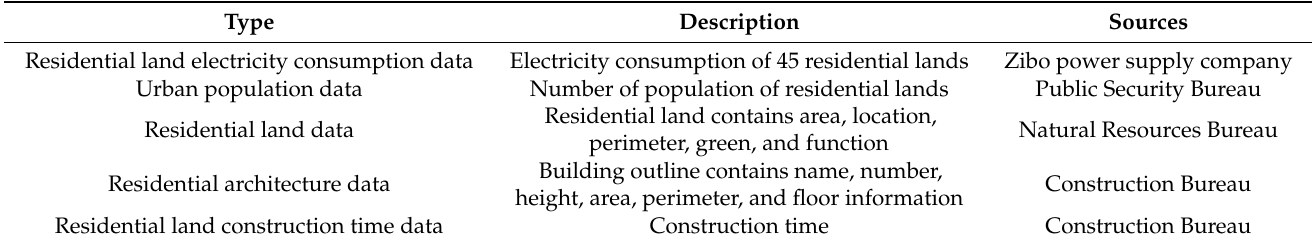
Table 1. Data sources and